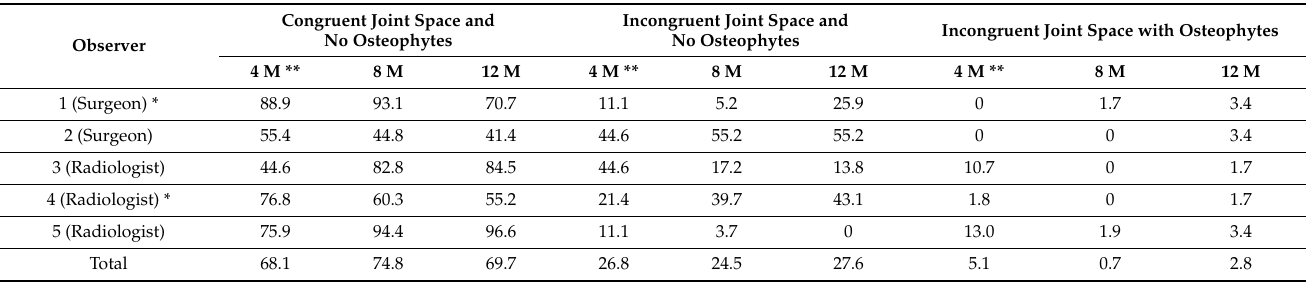
Table 5. Percentages (%) of evaluations of grading of degenerative joint disease (GDJD) by observers at 4 [29], 8, and 12 months of age.